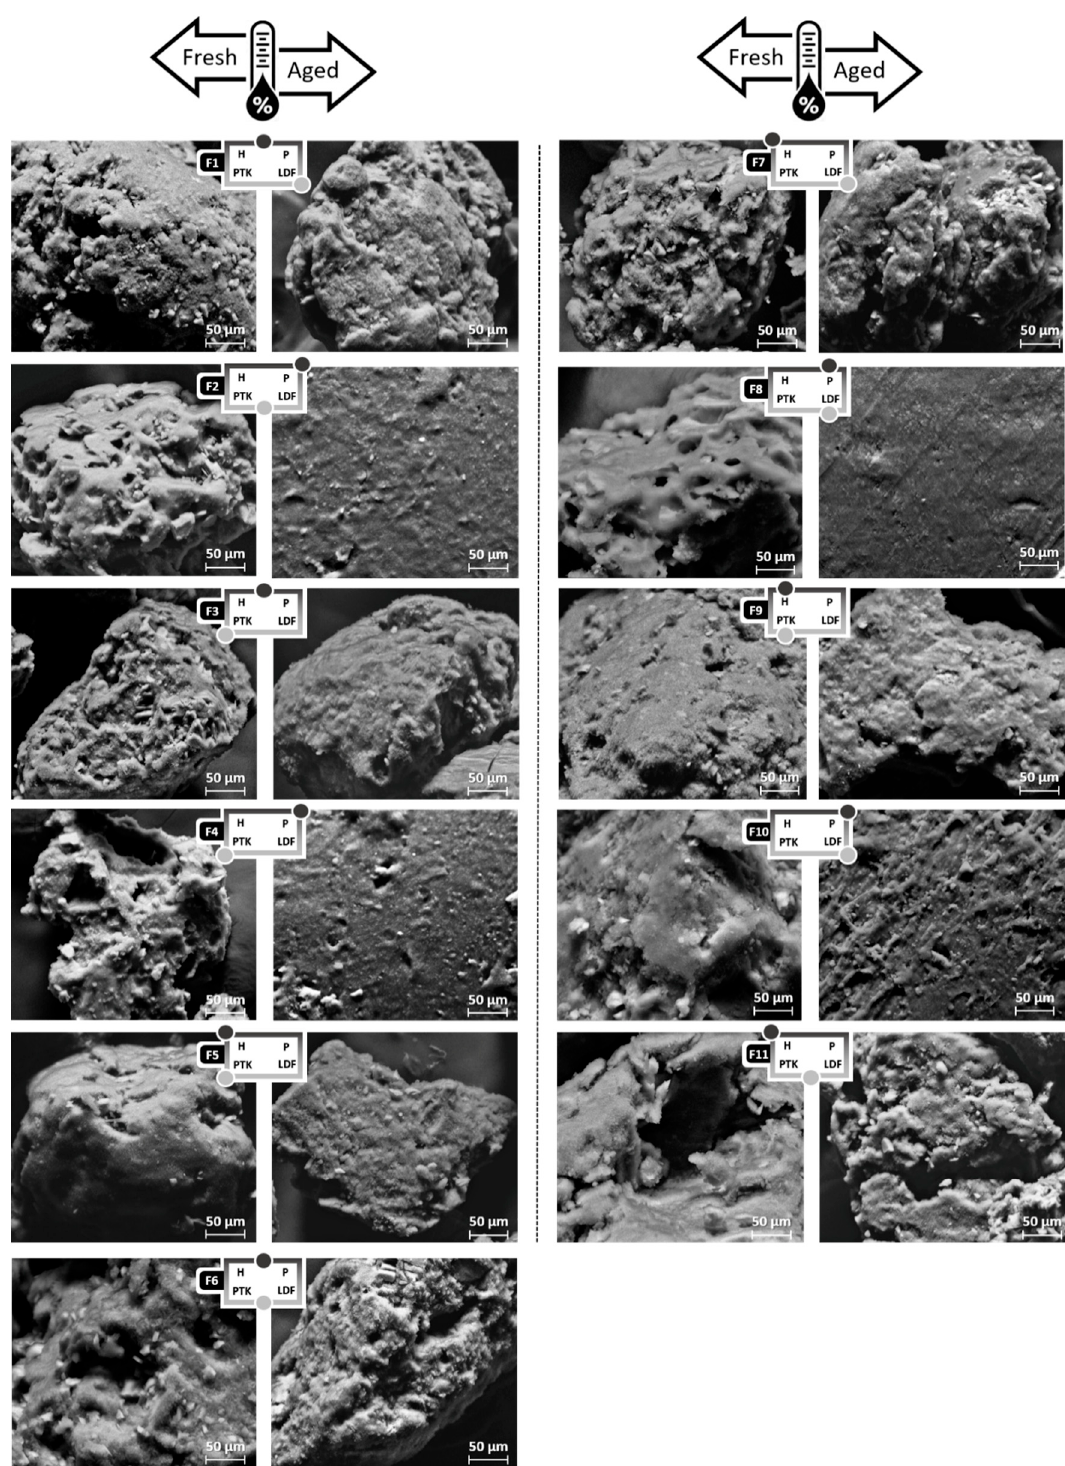
Figure 3. SEM photomicrographs of effervescent extrudates obtained according to a combined mixture design before and after aging at a 1000× magnification.